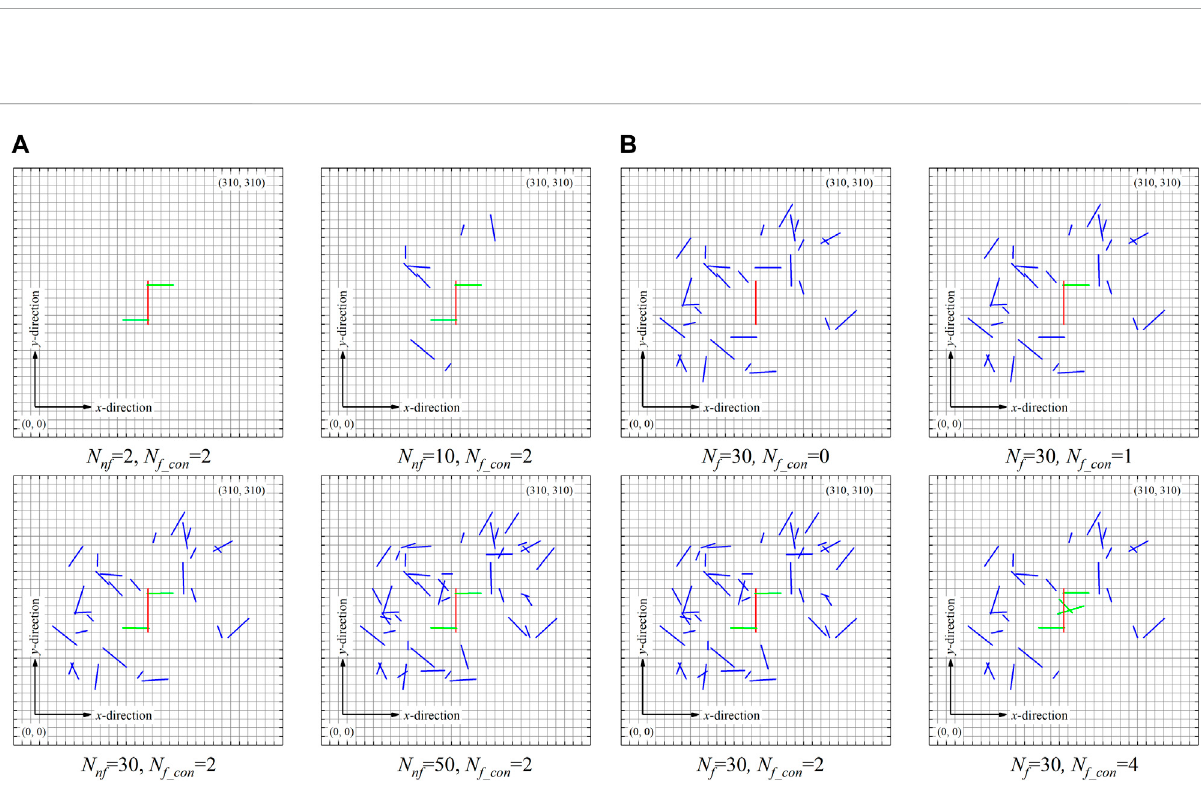
Schematicsofthedifferentscenariostoinvestigatetheeffectofthenumberofnaturalfractures: (A) differentvaluesof N nf withconstantvalueof N f_ con (B) constant value of N nf with different values of N f_con